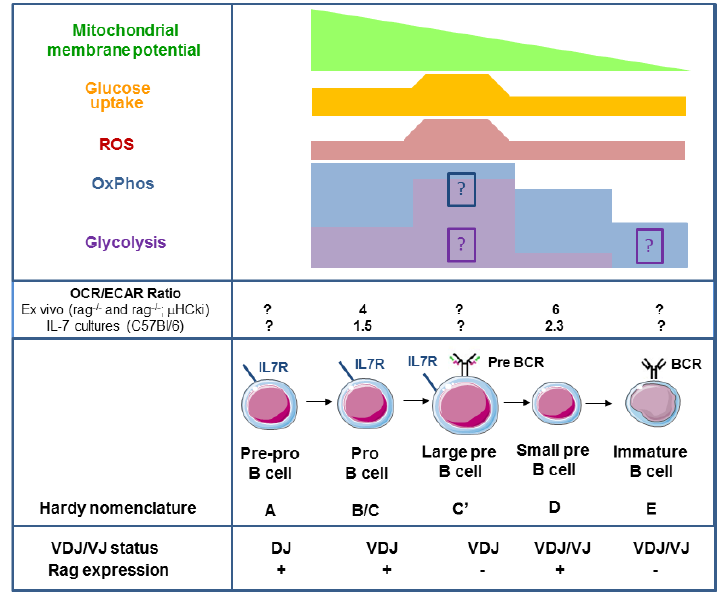
Figure 1. Relationship between oxidative phosphorylation and glycolysis during early murine B cell development. Summary of experimental determinations of the mitochondrial membrane potential Δψ m , glucose uptake, ROS production, Oxphos and glycolysis during B cell development from pro- to large and from small pre-B to immature B cells [21,22]. Extracellular flux analysis of pro- and small pre-B cells (mainly small) obtained from rag2 −/− or rag2 −/− ; μHC knock -in mice or from sorted wildtype pro- and pre-B cells (mainly small) obtained from IL-7 cultures revealed a decline in both glycolysis and OxPhos, with the decline in glycolysis being more pronounced [21]. Consequently, small pre-B cells show a higher OxPhos to glycolysis ratio in both systems, with a lower ratio observed in the IL- 7 cultures. Immature B cells reveal an even lower rate of OxPhos [22]. Missing data are indicated by question marks. The increase in glycolysis and OxPhos in large pre-B cells is speculative (see boxed question marks in matching colours) and based on literature reviews.